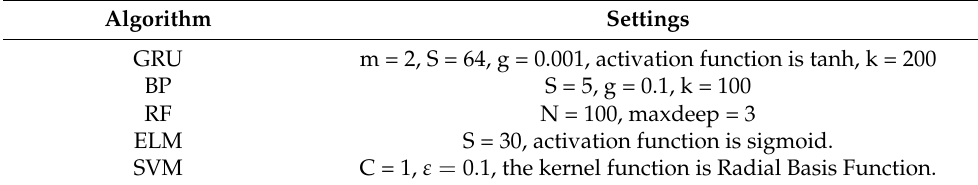
Table 2. Parameter settings of the five algorithms.